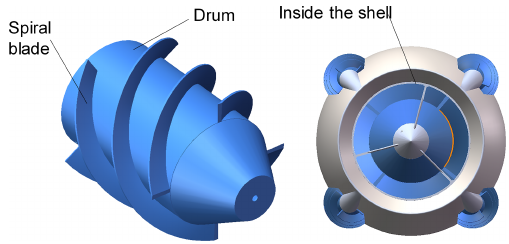
Figure 4. Schematic diagram of the spiral transport